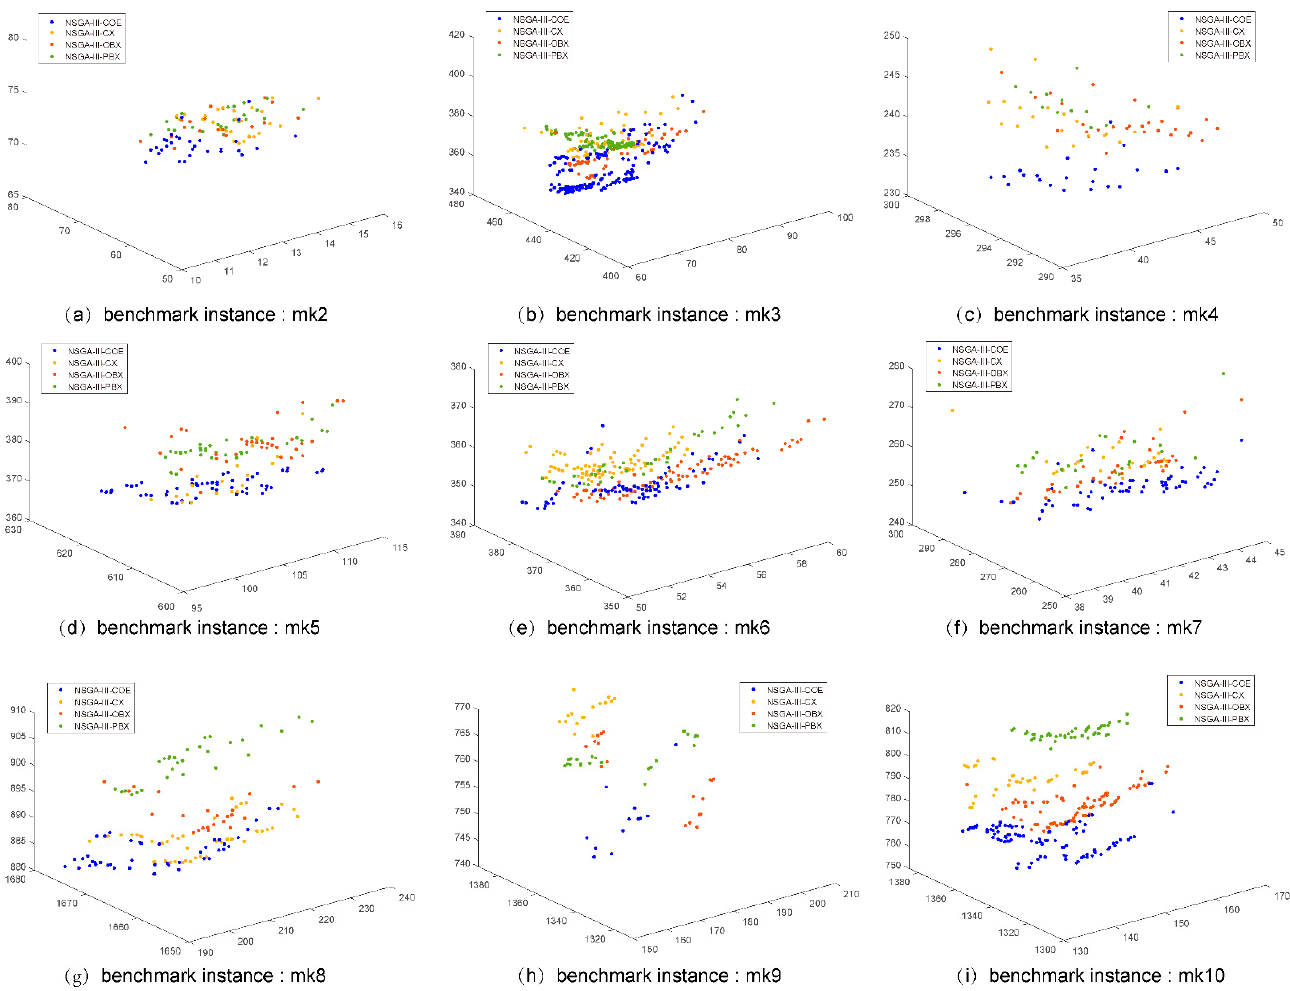
Figure 7. The non-dominated solutions of NSGA-III-COE, NSGA-III-CX, NSGA-III-OBX, and NSGA-III-PBX on instances mk2–mk10.